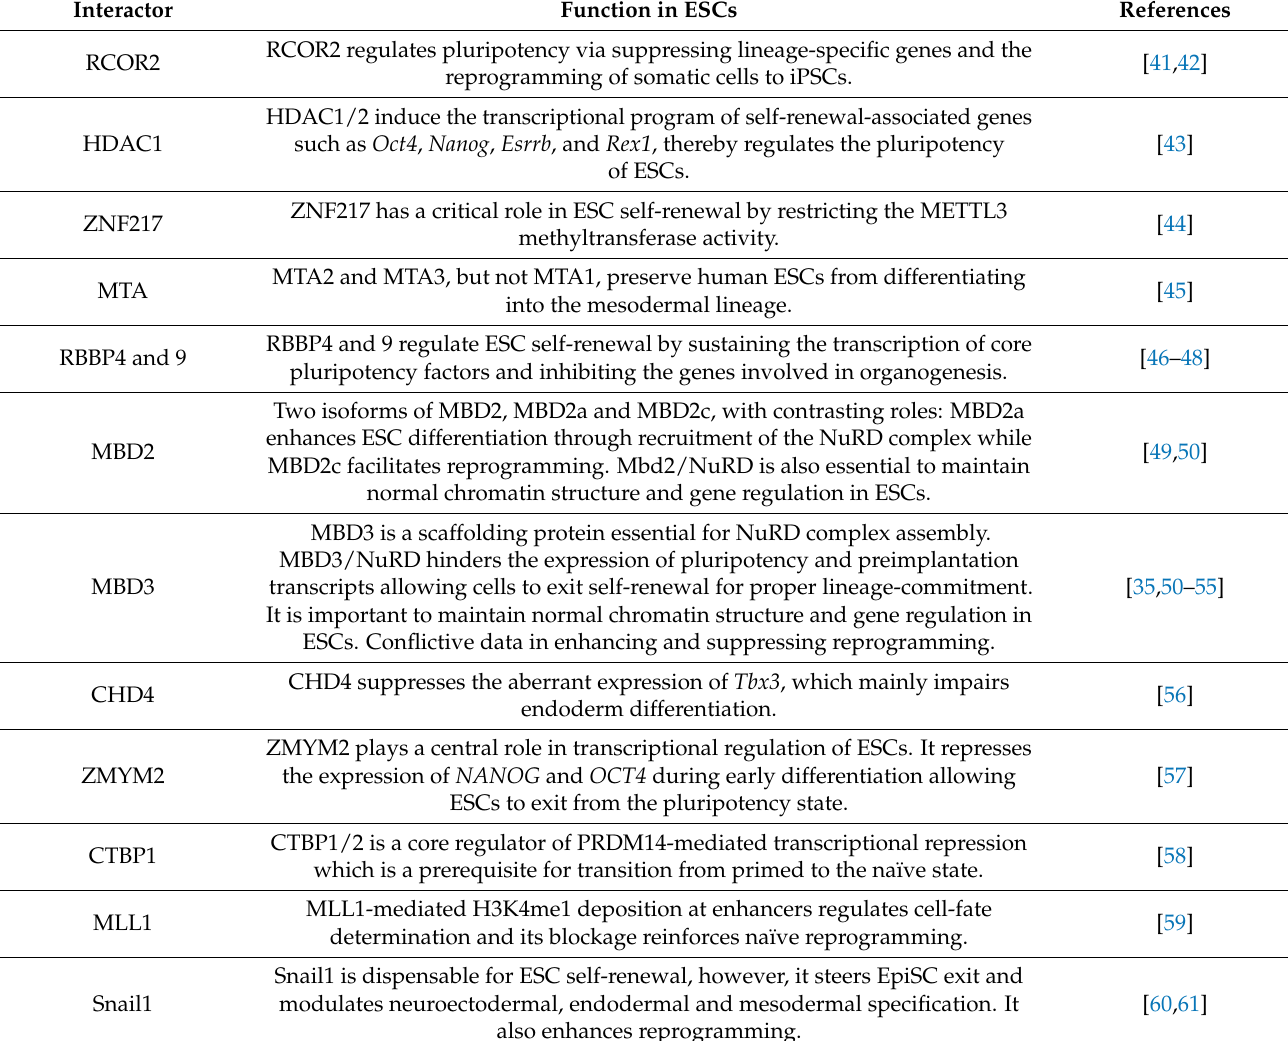
Table 1. Protein interactors of LSD1. Only interactors of LSD1 with a reported function in ESCs are shown. Interactor Function in